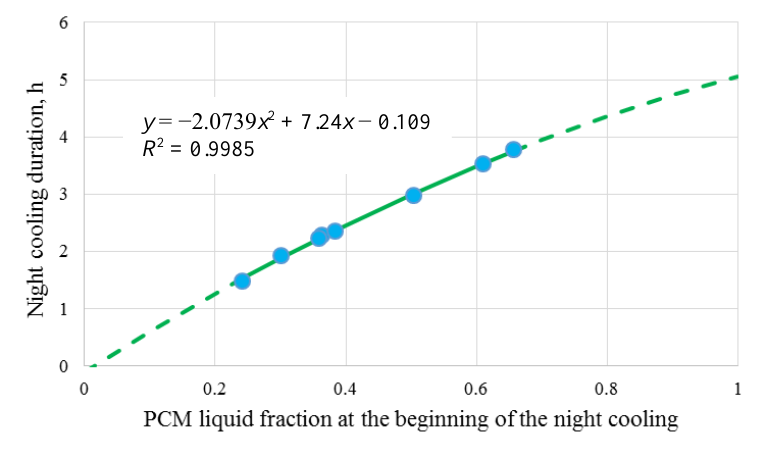
y = −2.0739 x 2 + 7.24 x − 0.109 R 2 =